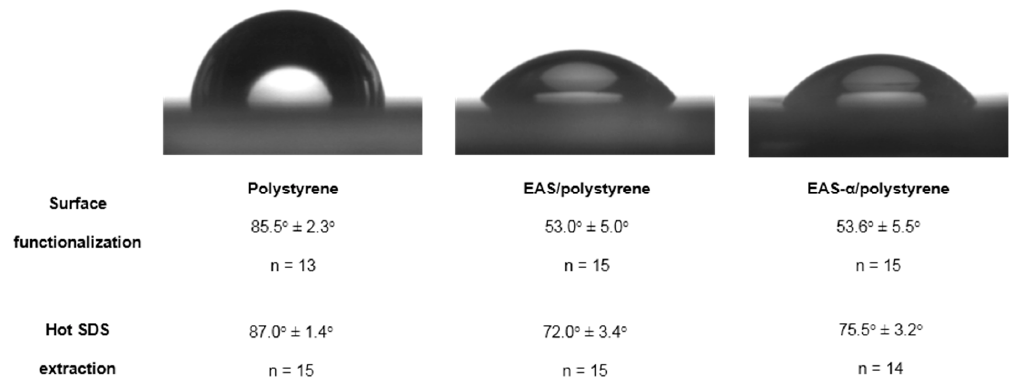
Figure 2. Water contact angle measurements of pure and hydrophobin-functionalized polystyrene surfaces. Polystyrene supports were functionalized with EAS and EAS- α as detailed in Materials and Methods and water contact angles were determined (images and upper panel). To analyze hydrophobin layer stability, the surfaces were additionally treated with hot SDS solutions prior to contact angle measurement ( lower panel).